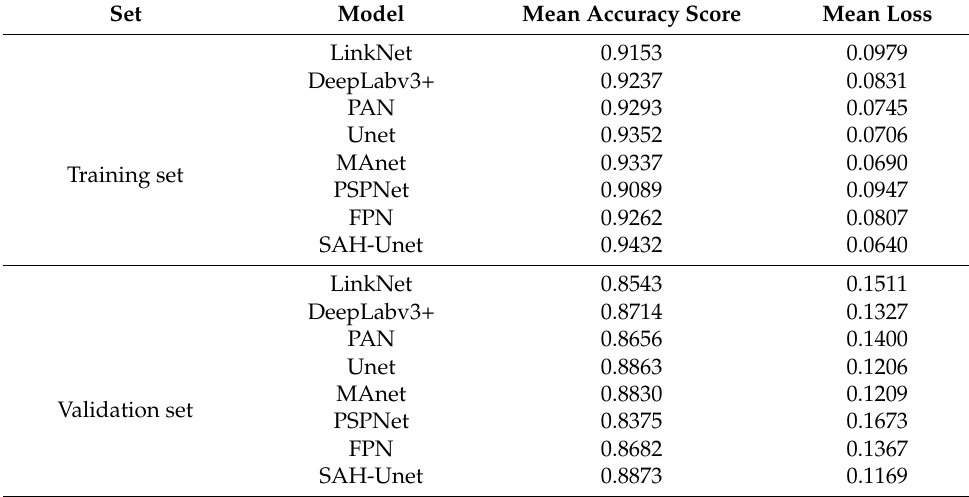
Table 3. Comparison table of model training and test results.